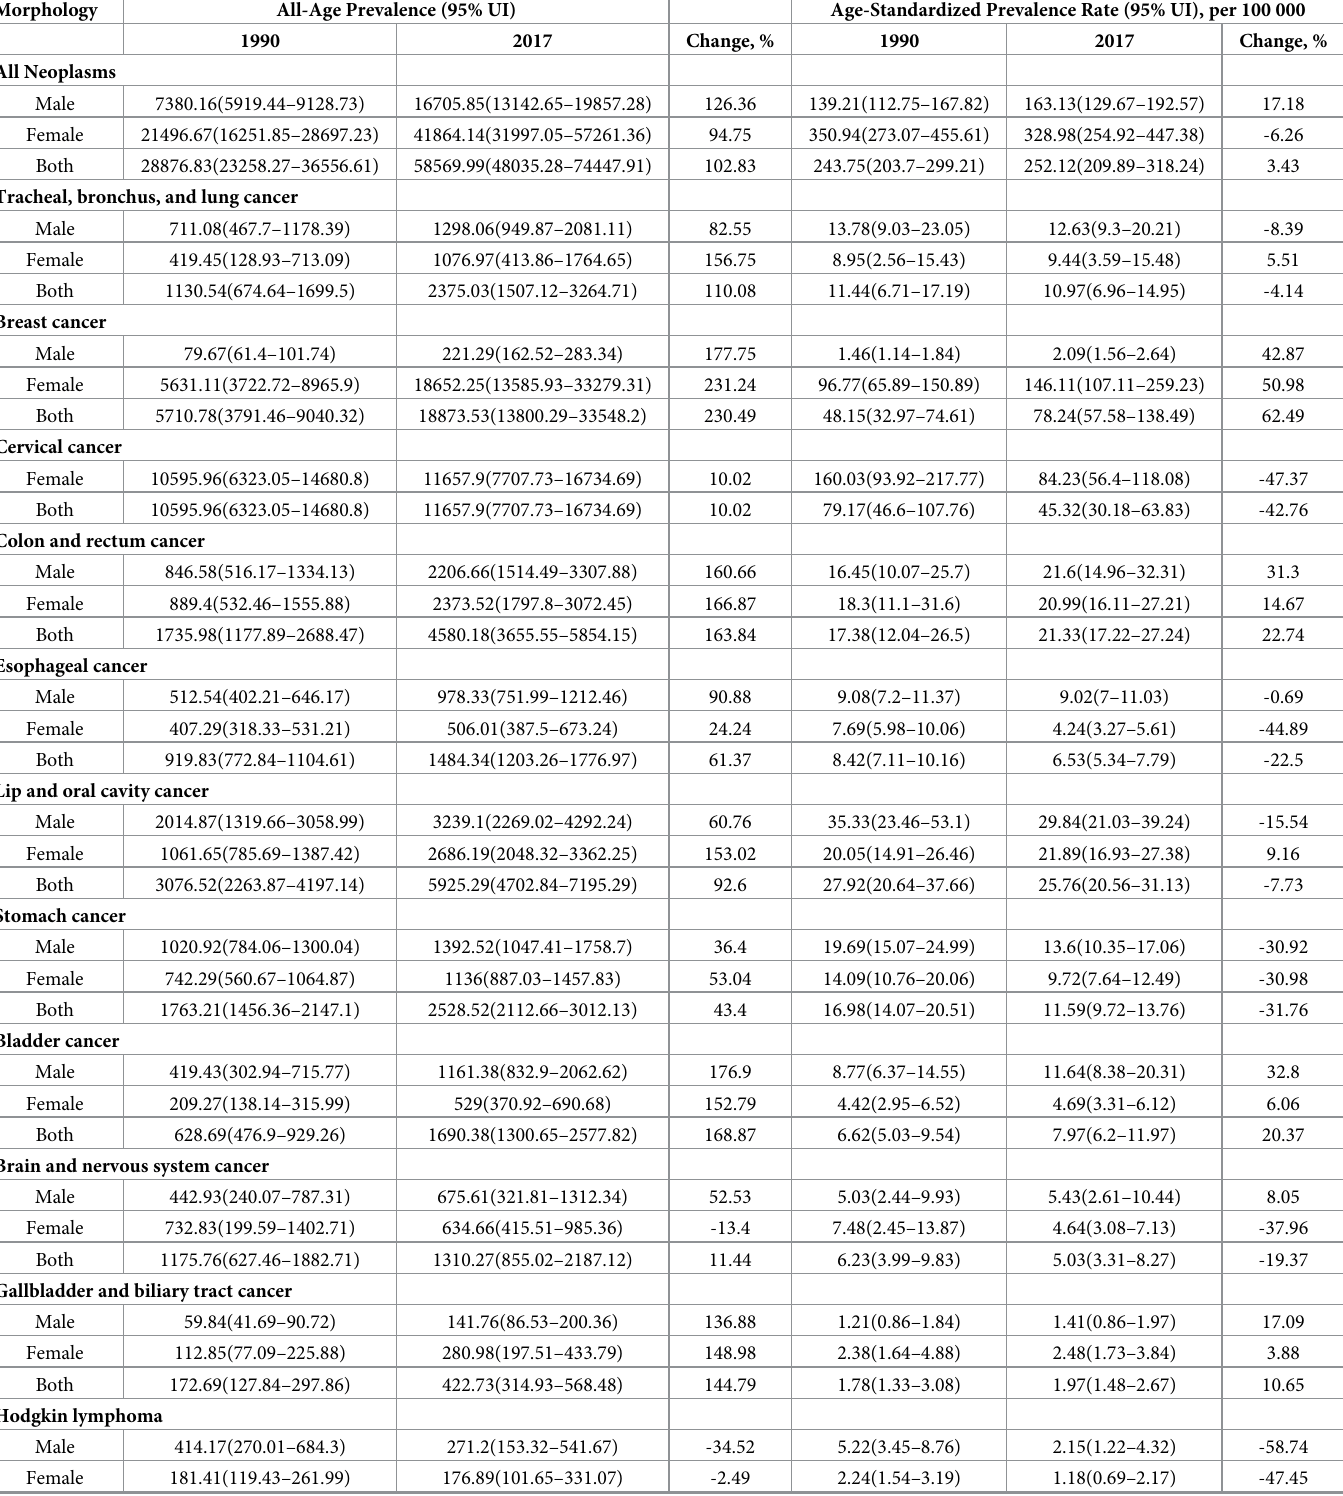
Table 3. All-age prevalence and age-standardized prevalence rates for different types of cancer and their percentage change by gender in Nepal, 1990–2017.